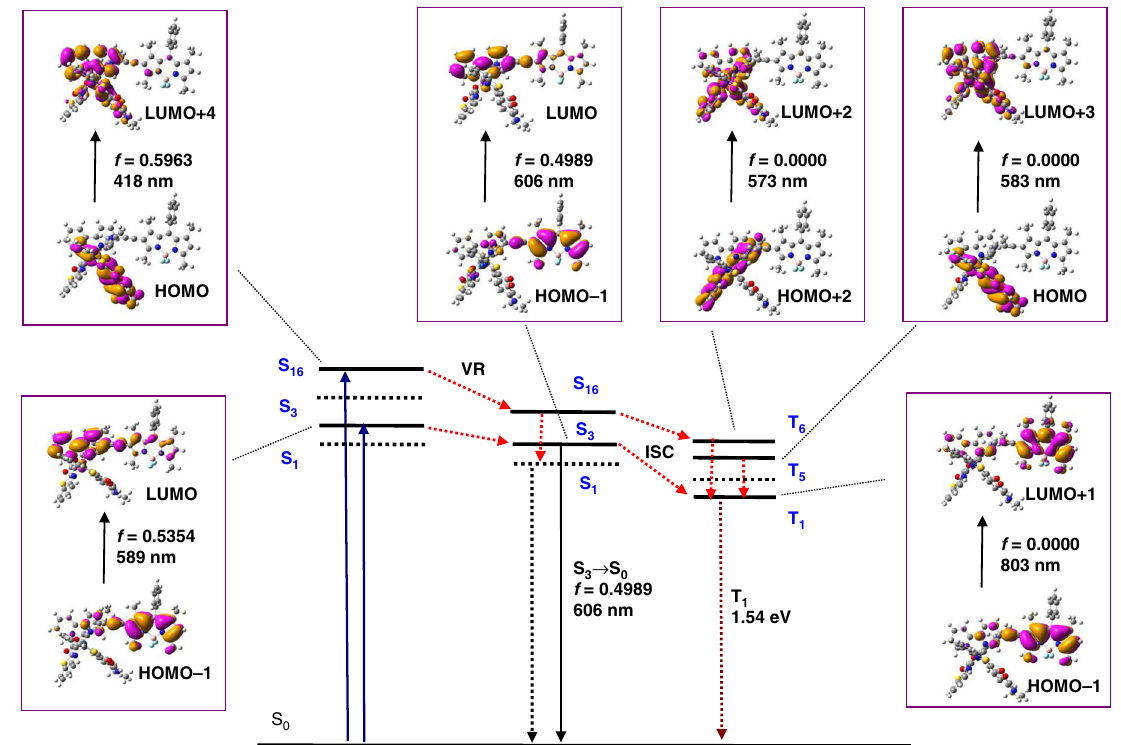
Fig. 8 Selected frontier molecular orbitals involved in the excitation and singlet excited state/triplet excited state (TES) of Ir-4. VR stands for vibrational relaxation. The left column is ultraviolet – visible absorption (based on ground state geometry), the middle column is the fl uorescence emission (based on S 1 state geometry), and the right column is the TES (based on ground state geometry). For clarity, only selected excited states are presented